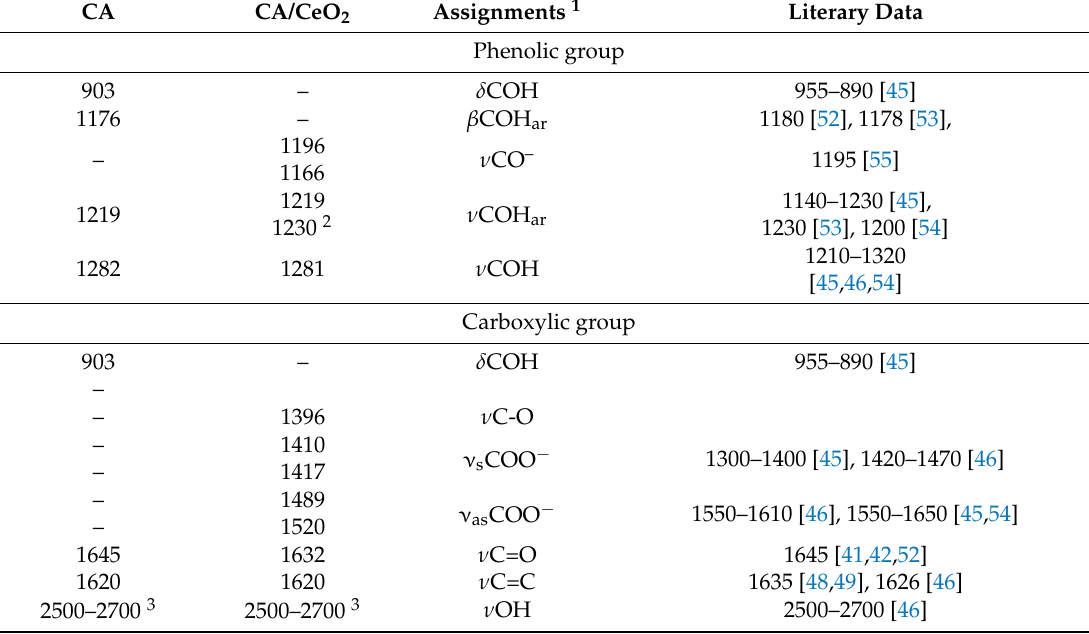
Table 1. Assignments of some characteristic infrared (IR) bands (cm − 1 ) of CA in condensed phase and CA on the surface of CeO 2